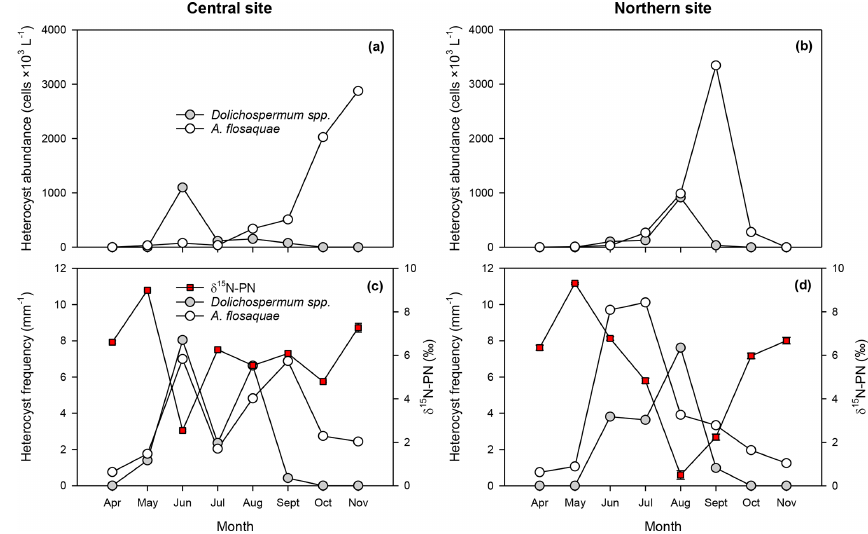
Figure 6. Abundance of heterocysts of Dolichospermum spp. and A. flos-aquae (a, b) , heterocyst frequency per filament length and stable isotope composition of particulate nitrogen ( δ 15 N-PN) (c, d) at central (surface, left panels) and northern sites (right panels) in the Curonian Lagoon during 2018. δ 15 N-PN values are mean and standard error based on three replicates (some error bars are not